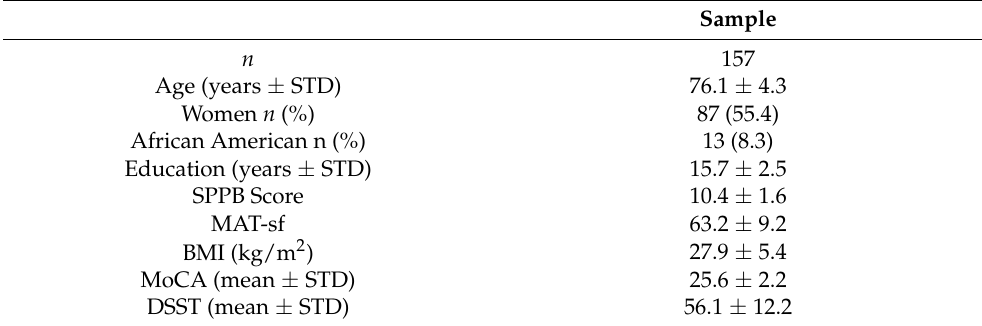
Table 1. General characteristics of